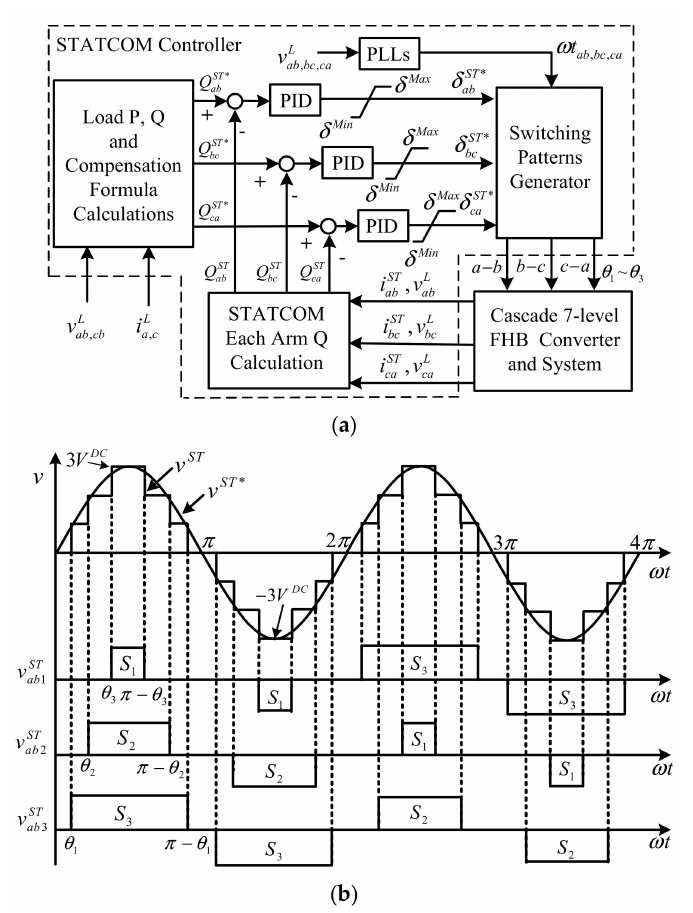
Figure 3. The proposed STATCOM controller and gating sequence ( a ) The STATCOM controller; ( b ) Alternate swapping of switching patterns for dc-link voltages